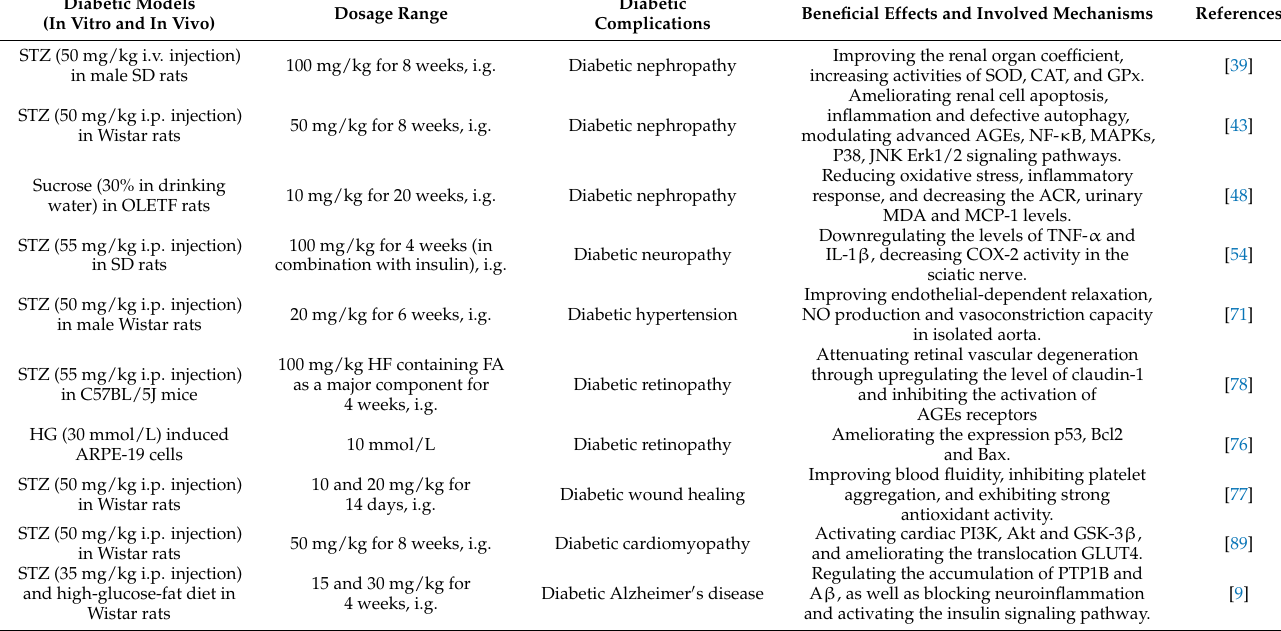
Table 2. Major effects of FA in management of diabetes